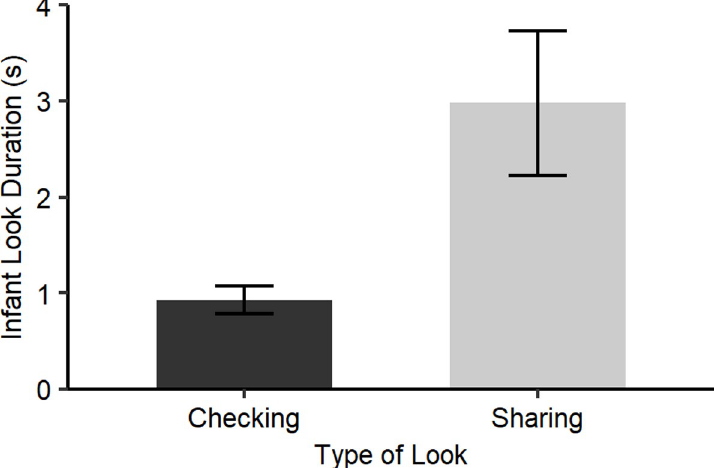
Fig 1. Mean duration of look from infant to mother for ‘high agreement’ looks that were rated as “Checking looks” and “Sharing looks” by the majority of participants, with SEM error bars.